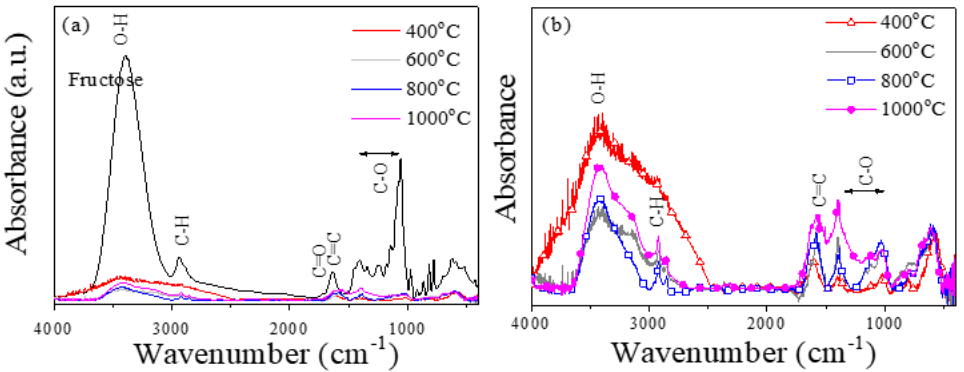
Figure 2. FTIR spectra of the ( a ) MNPs + fructose samples annealed at different temperatures. Fructose spectrum is also included for comparison. ( b ) Enlargement of the spectra of the annealed samples.